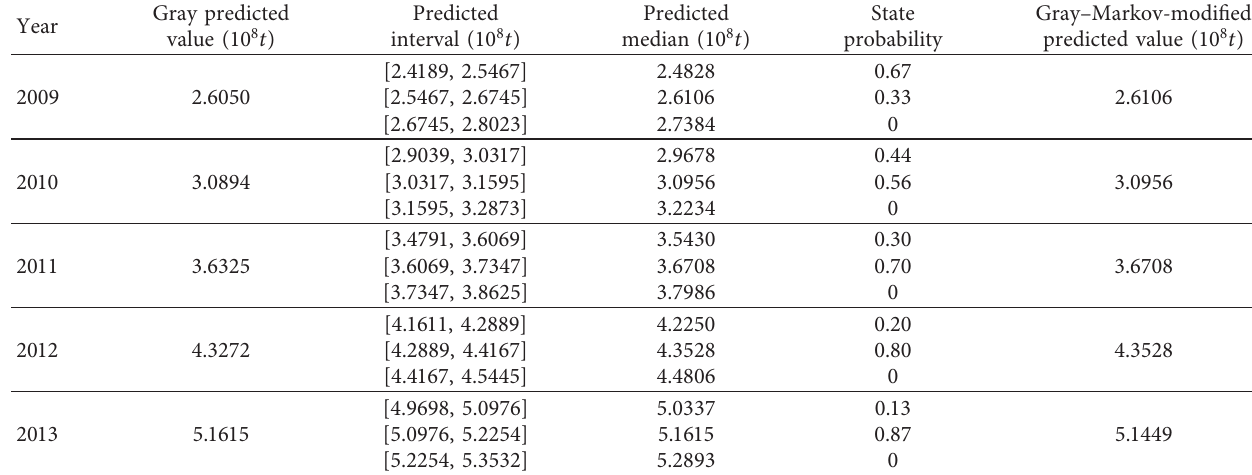
Table 4: Xi’an’s predicted freight volume from 2009 to 2013 based on the Gray–Markov model. Gray predicted Year